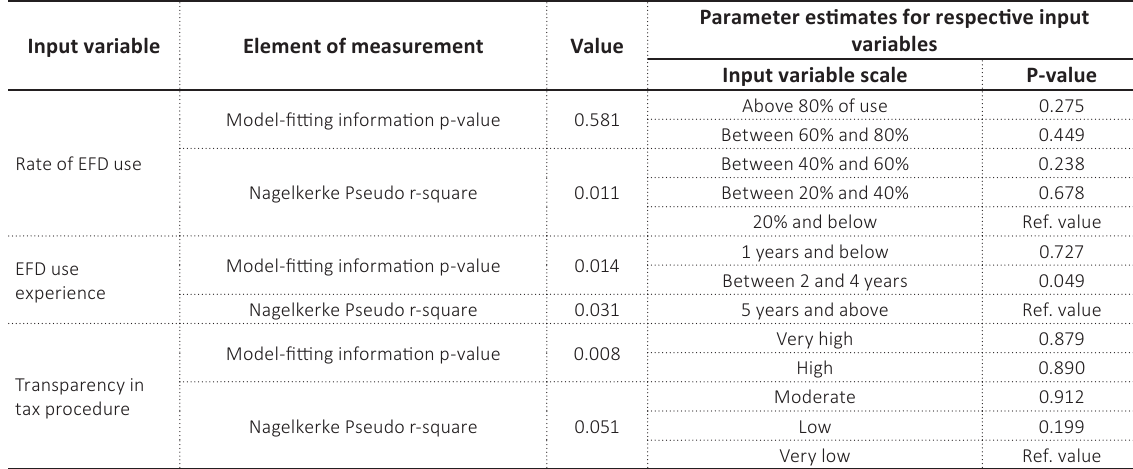
Table 6. Ordinal regression results between different variables and tax